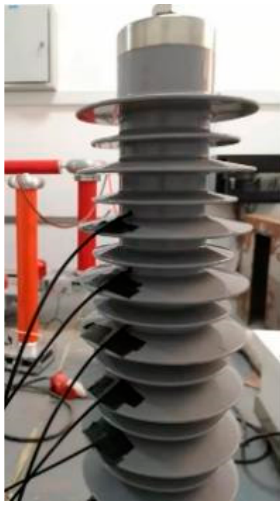
Figure 2. Customized arrester structure.